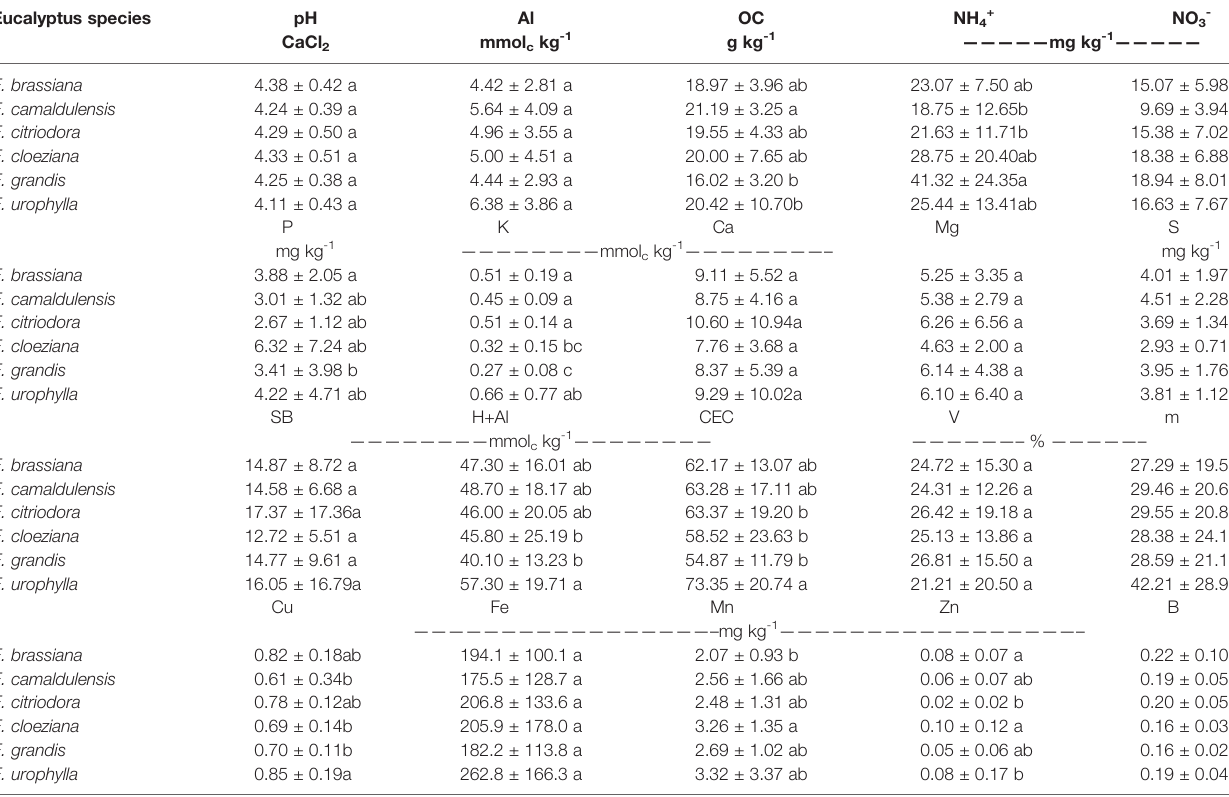
TABLE 1 | Soil chemical attributes in Eucalyptus